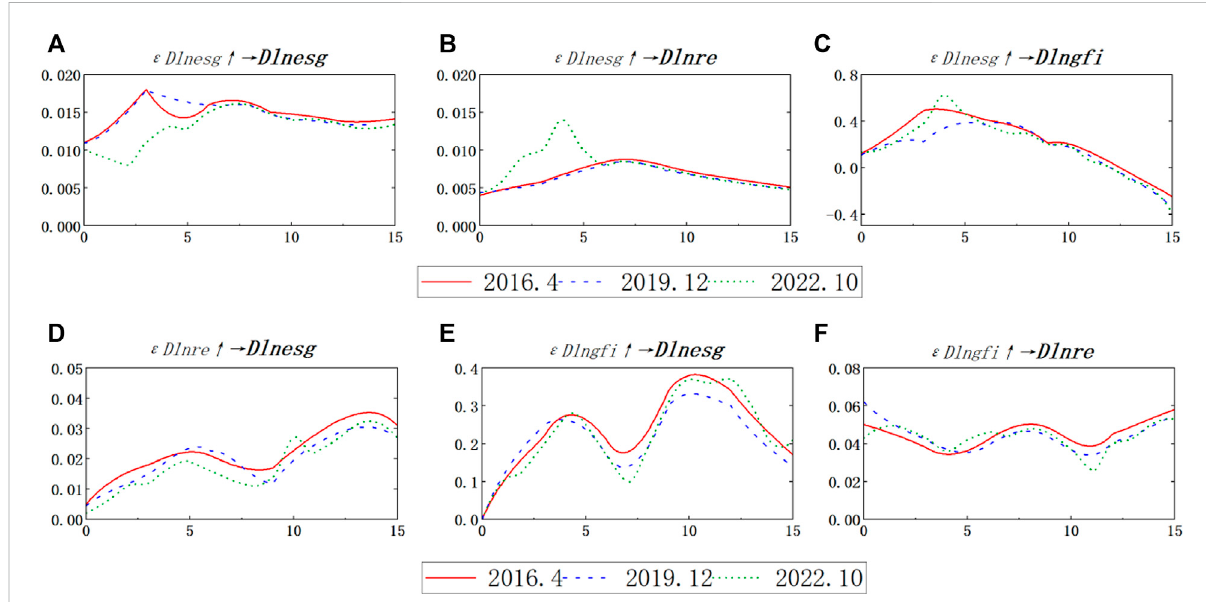
FIGURE 8 Time-point impulse response diagrams. (A) The time-point impulse response of sustainability, (B) the time-point impulse response of sustainabledevelopmenttorenewableenergy, (C) thetime-pointimpulseresponseofsustainabledevelopmenttogreen fi nance, (D) thetime-point impulse response of renewable energy to sustainable development, (E) the time-point impulse response of green fi nance to sustainable development, (F) the time-point impulse response of green fi nance to renewable